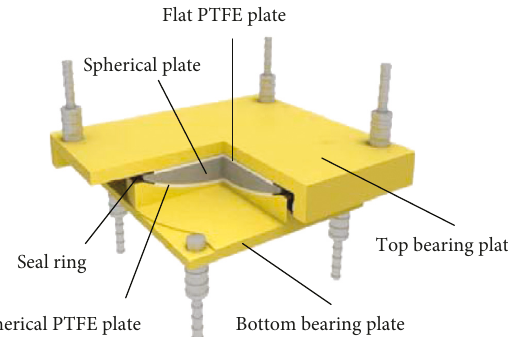
Figure 1: The components of spherical steel